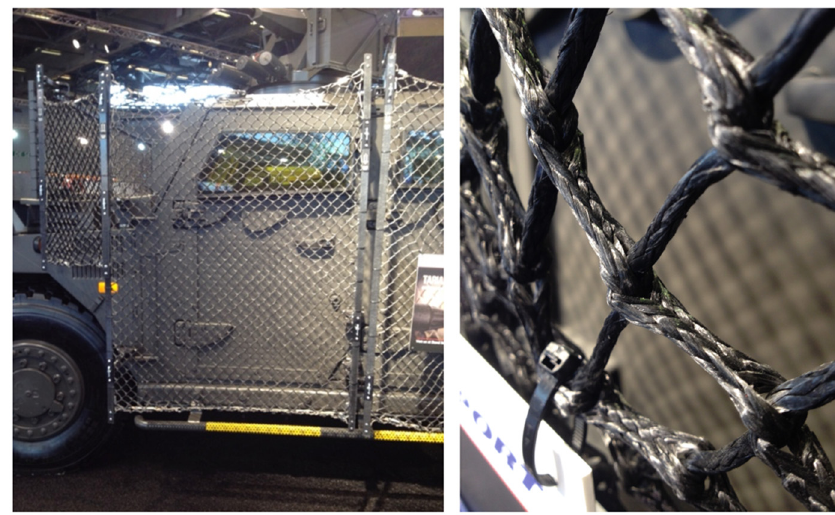
Figure 8. Polymer fibre-based net cage armour mounted on a light armoured vehicle.